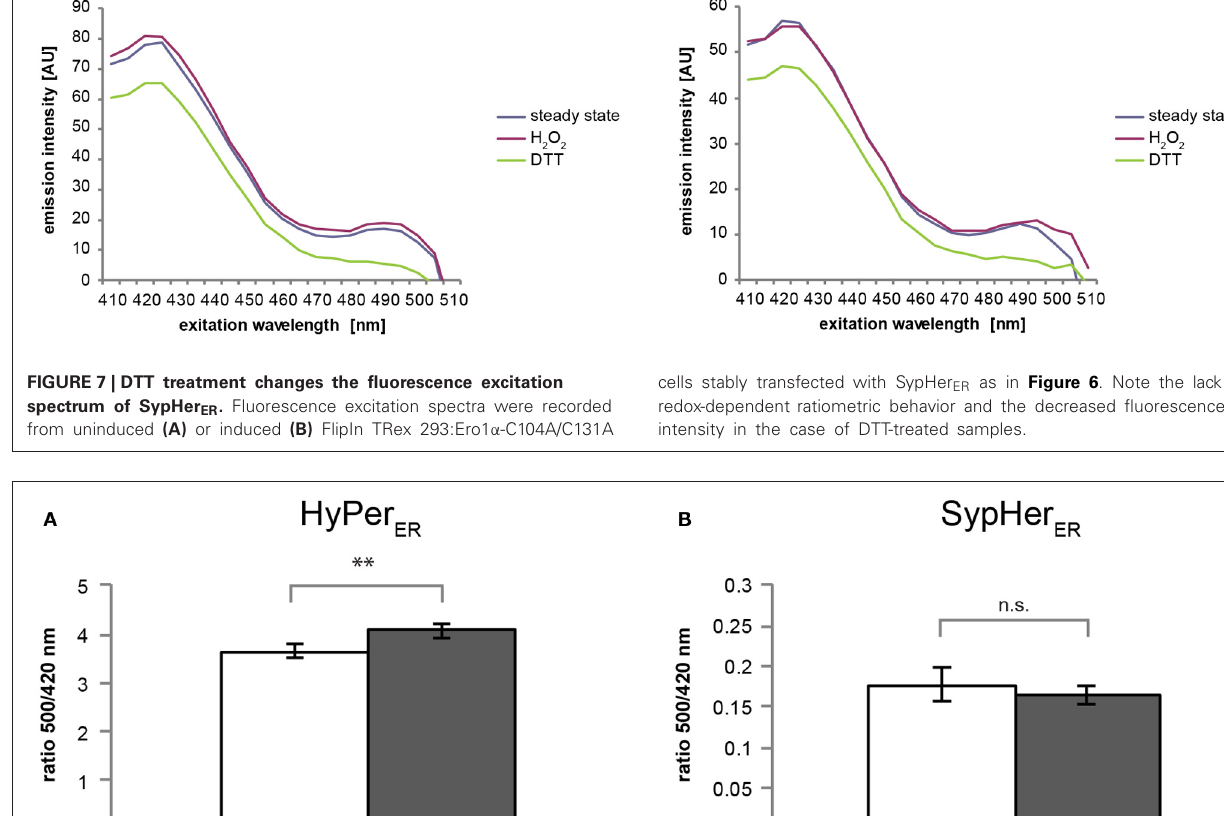
wereobtainedas shownin Figures 6 , 7 , respectively. Data setswere analyzed for statistical significance using student’s T -test (two-tailed distribution; heteroscedastic) ( n ≥ 3; mean ± SD). Dox, doxycycline; ∗∗ p = 0 .